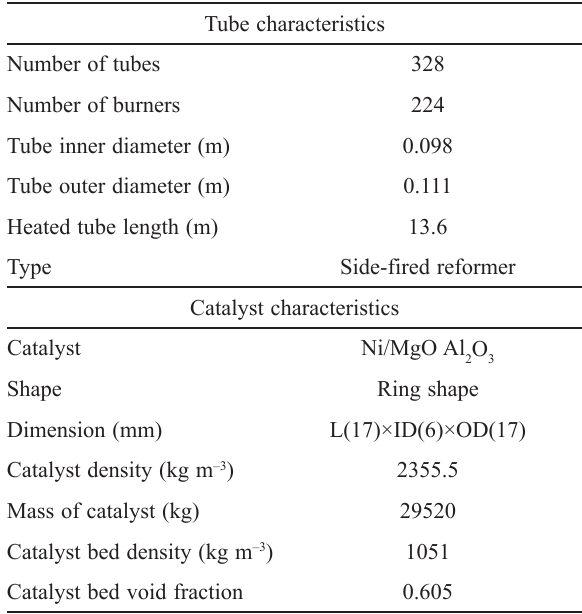
Table 1 – Characteristics of steam methane reformer in Ban­ dar Abbas refinery,